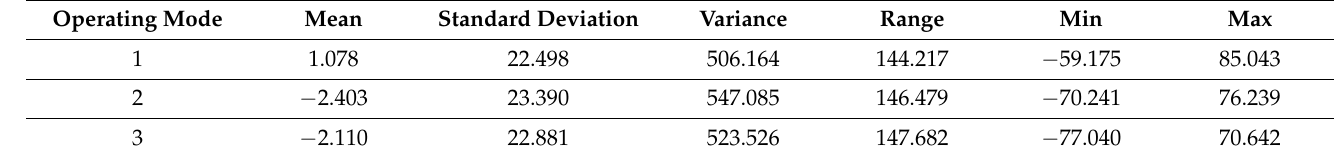
Table 8. Statistical summary of the calculated power residuals of each operating